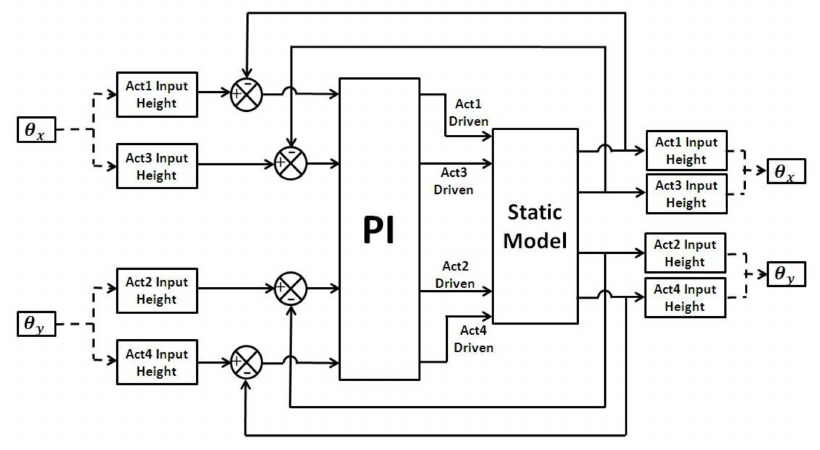
Figure 8. The block diagram of the control system with four inputs and